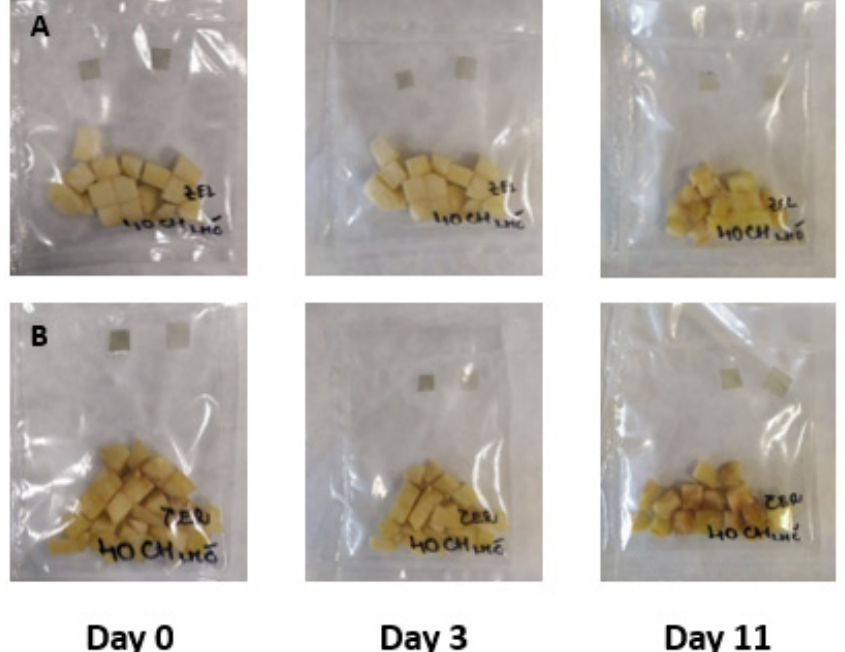
Figure 4. Green ( A ) and red ( B ) apples packaged with pieces of film made with the addition of blue tea.